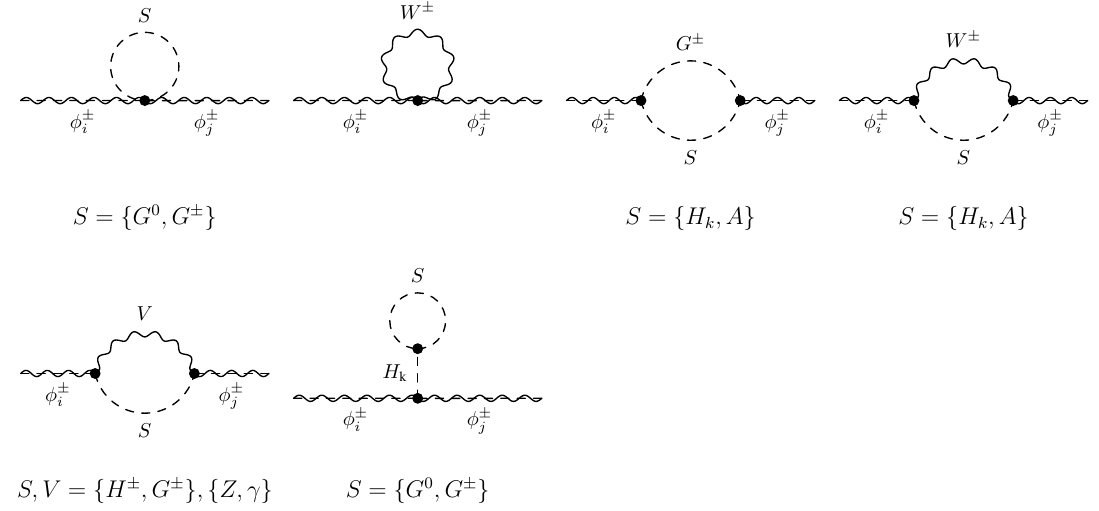
Figure 14 . All Feynman diagrams contributing to the gauge-dependence of the charged self- energies (cid:6) tad ( p 2 ) where (cid:30) (cid:6) 2 f W; G (cid:6) ; H (cid:6) g . A sum over intermediate Higgs states H k is assumed i;j (cid:30) (cid:6) i (cid:30) (cid:6) j wherever they appear. Overlapping dashed and twiggled lines denote a scalar or a gauge boson, respectively, depending on the chosen particles. Note that we only consider contributions to the extended scalar sector of the N2HDM. Depending on the particles (cid:30) (cid:6) chosen, some of the diagrams i;j shown may not exist in the